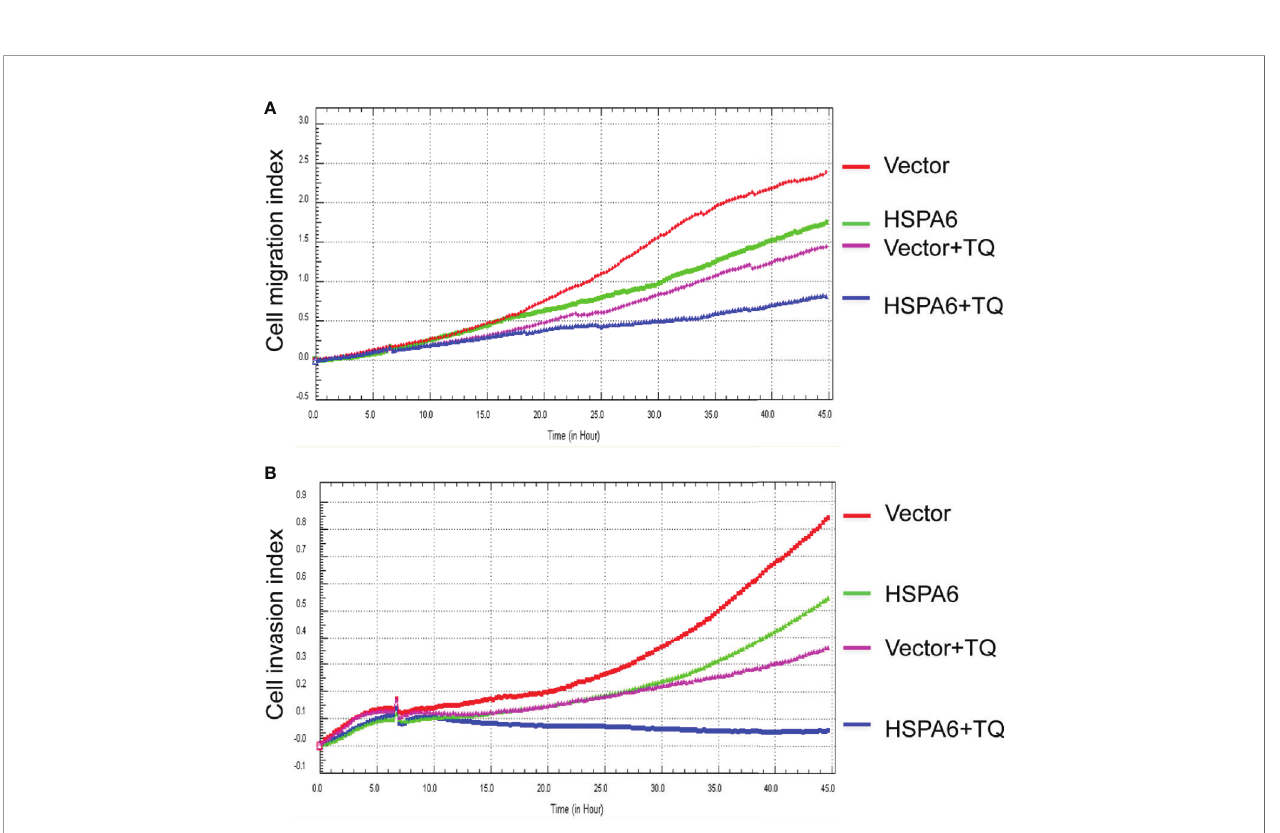
FIGURE 4 | TQ enhances the inhibitory effect of cell migration and invasion when overexpression of HSPA6, demonstrating a partially dependent manner on HSPA6. (A) Cell migration. (B) Cell invasion. The ef fi ciency for overexpression of HSPA6 was shown in Figure 2A . “ vector ” indicates the empty vector without HSPA6 expression, whereas “ HSPA6 ” indicates overexpression of